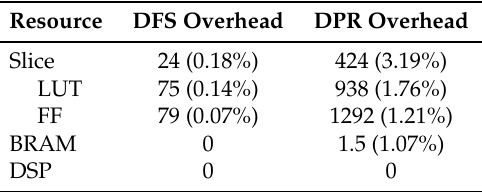
Table 4. Post-implementation resource overhead for DFS and DPR. The figures in parenthesis correspond to the percentage of available FPGA